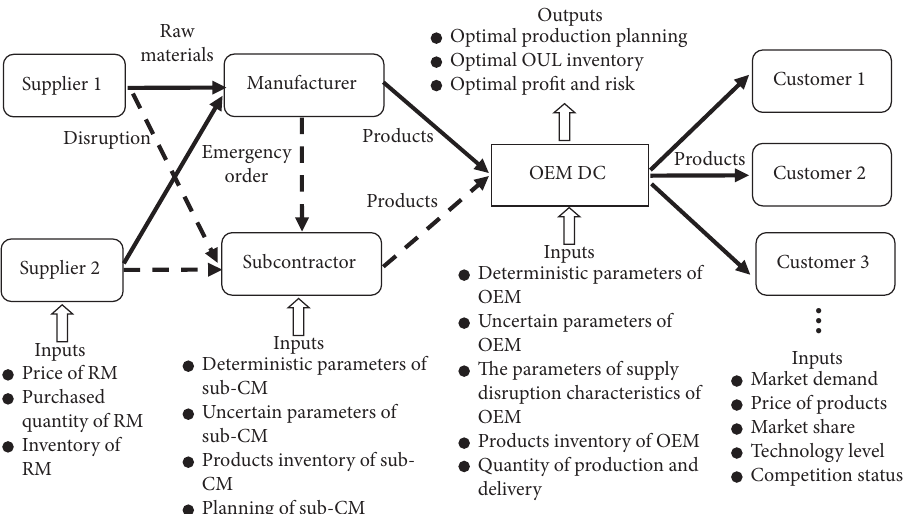
Figure 2: The system dynamics simulation model on dynamic supply